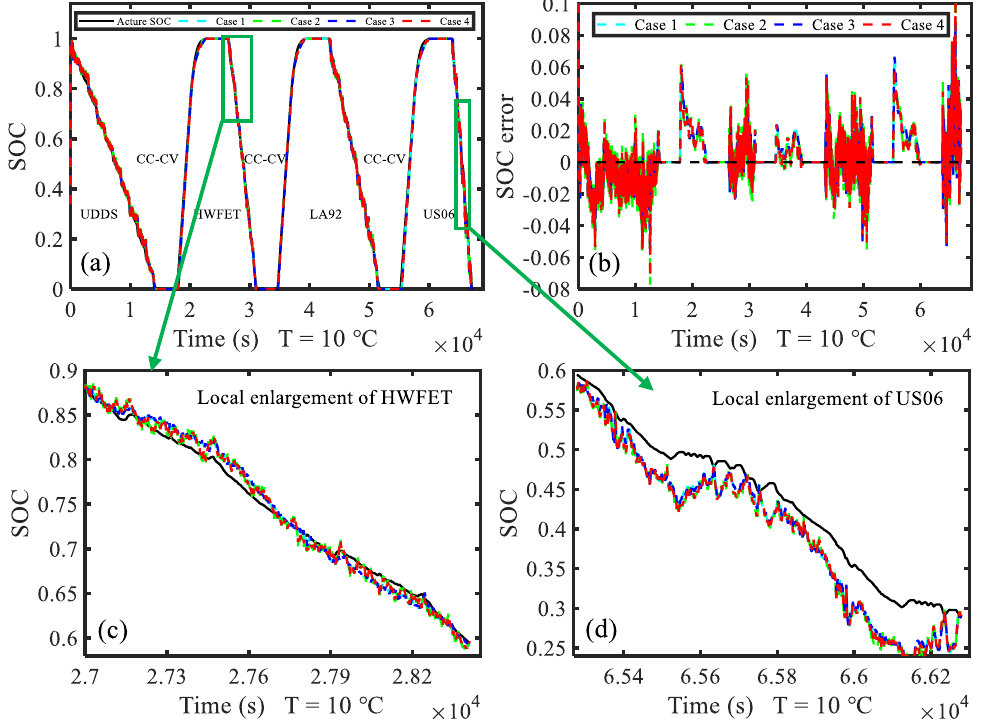
Figure 9. SOC and SOC error of long short-term memory (LSTM) model in four cases at 10 °C: ( a ) SOC, ( b ) SOC error, ( c ) local enlargement of HWFET, ( d ) local enlargement of US06.